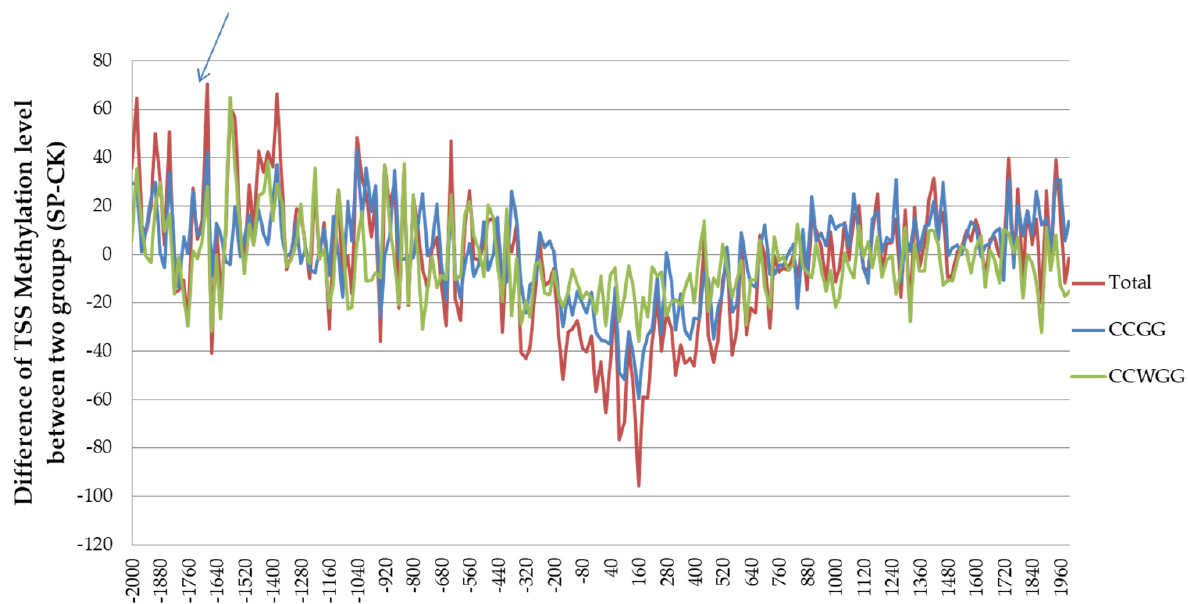
Figure 8. Differences in DNA methylation levels at the TSS region between the SP and CK groups. Note: The arrow indicates the highest difference in methylation levels between SP and CK groups at about − 1690 bp.